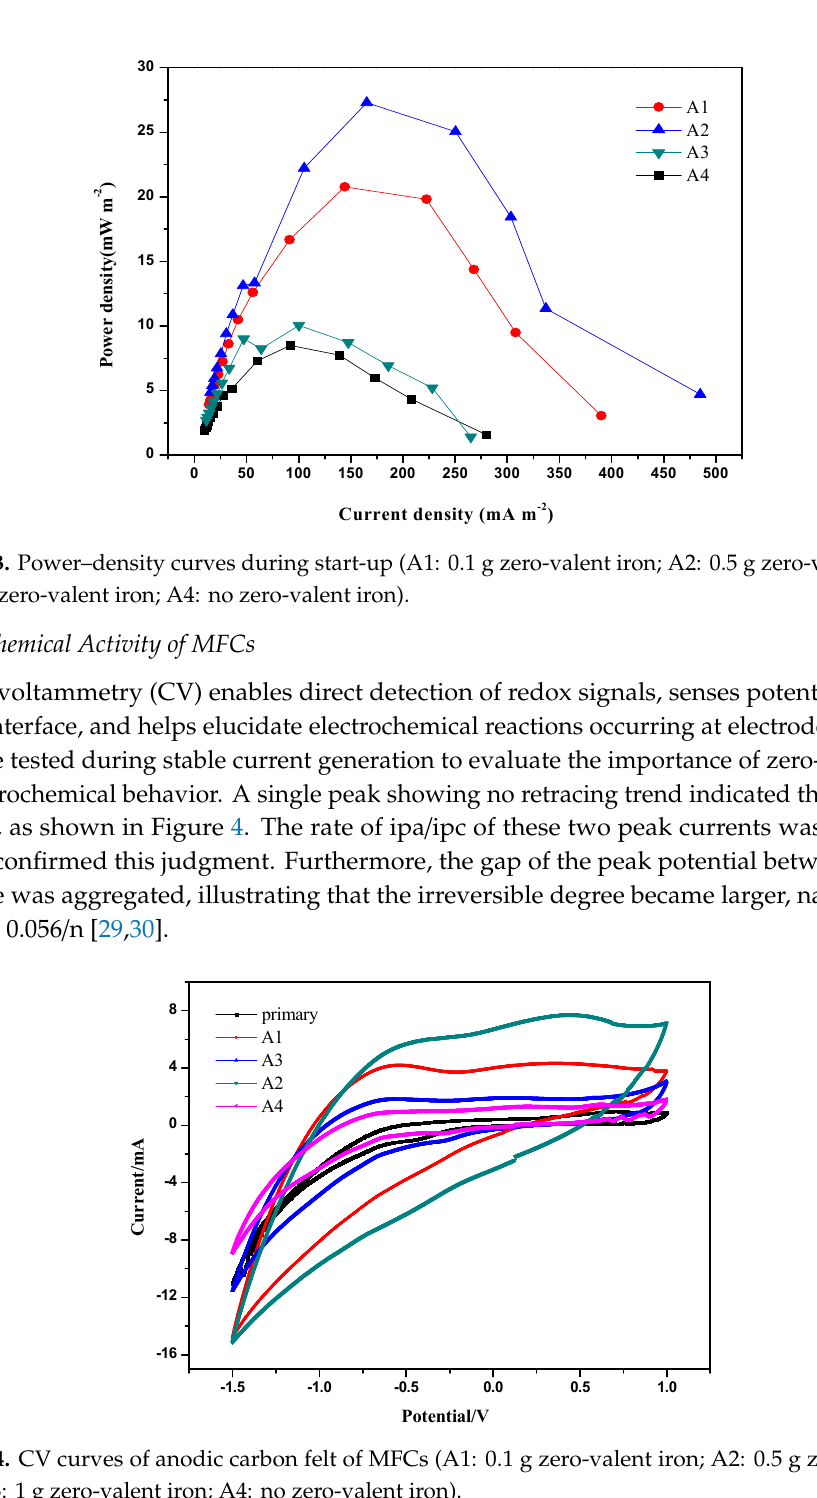
Figure 3. Power–density curves during start-up (A1: 0.1 g zero-valent iron; A2: 0.5 g zero-valent iron; A3: 1 g zero-valent iron; A4: no zero-valent iron).